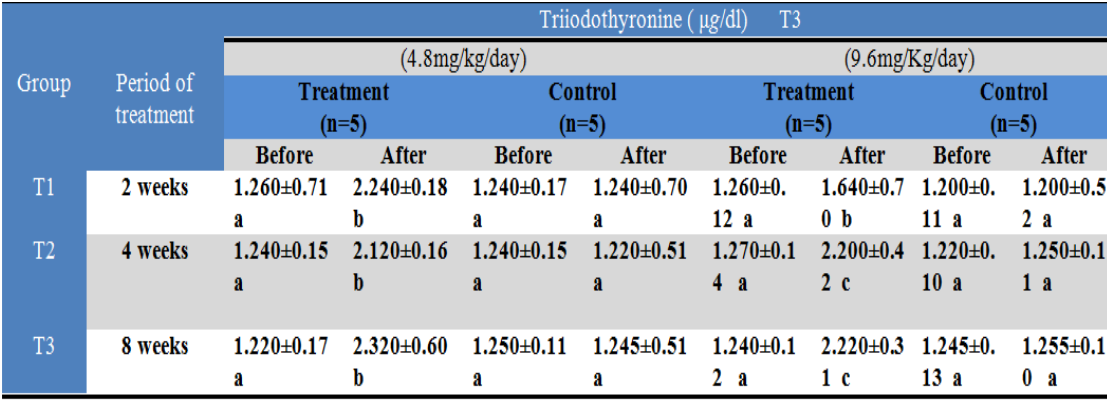
Table 2: Effect of orally administering a low dose (4.8mg/kg/day) and double dose (9.6mg/Kg/day) of Citrullus colocynthis on triiodothyronine hormone levels (μg/dl) of male rabbits in different periods.